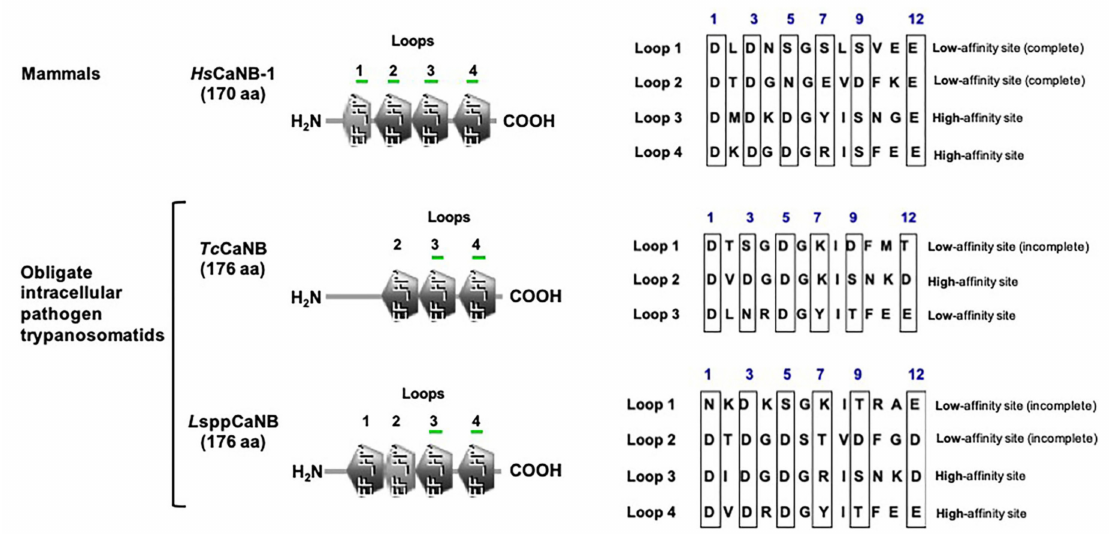
Figure 6. Protein domain architecture in CaNB. Representative scheme of the EF-hand motifs in mammalian CaNB ( Hs CaNB-1) and in the obligate intracellular trypanosomatids ( Tc CaNB and L sppCaNB) showing the loops (numbered) containing the calcium affinity binding sites (green underline) with the different amino acids sequences on the right. The blue number over the box represents coordinating sites for Ca 2+ .